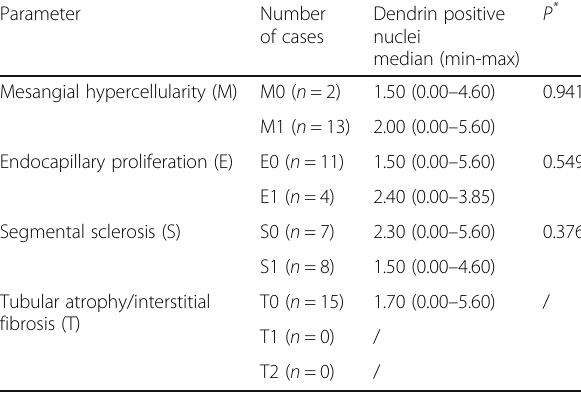
Table 3 Number of dendrin positive nuclei according to